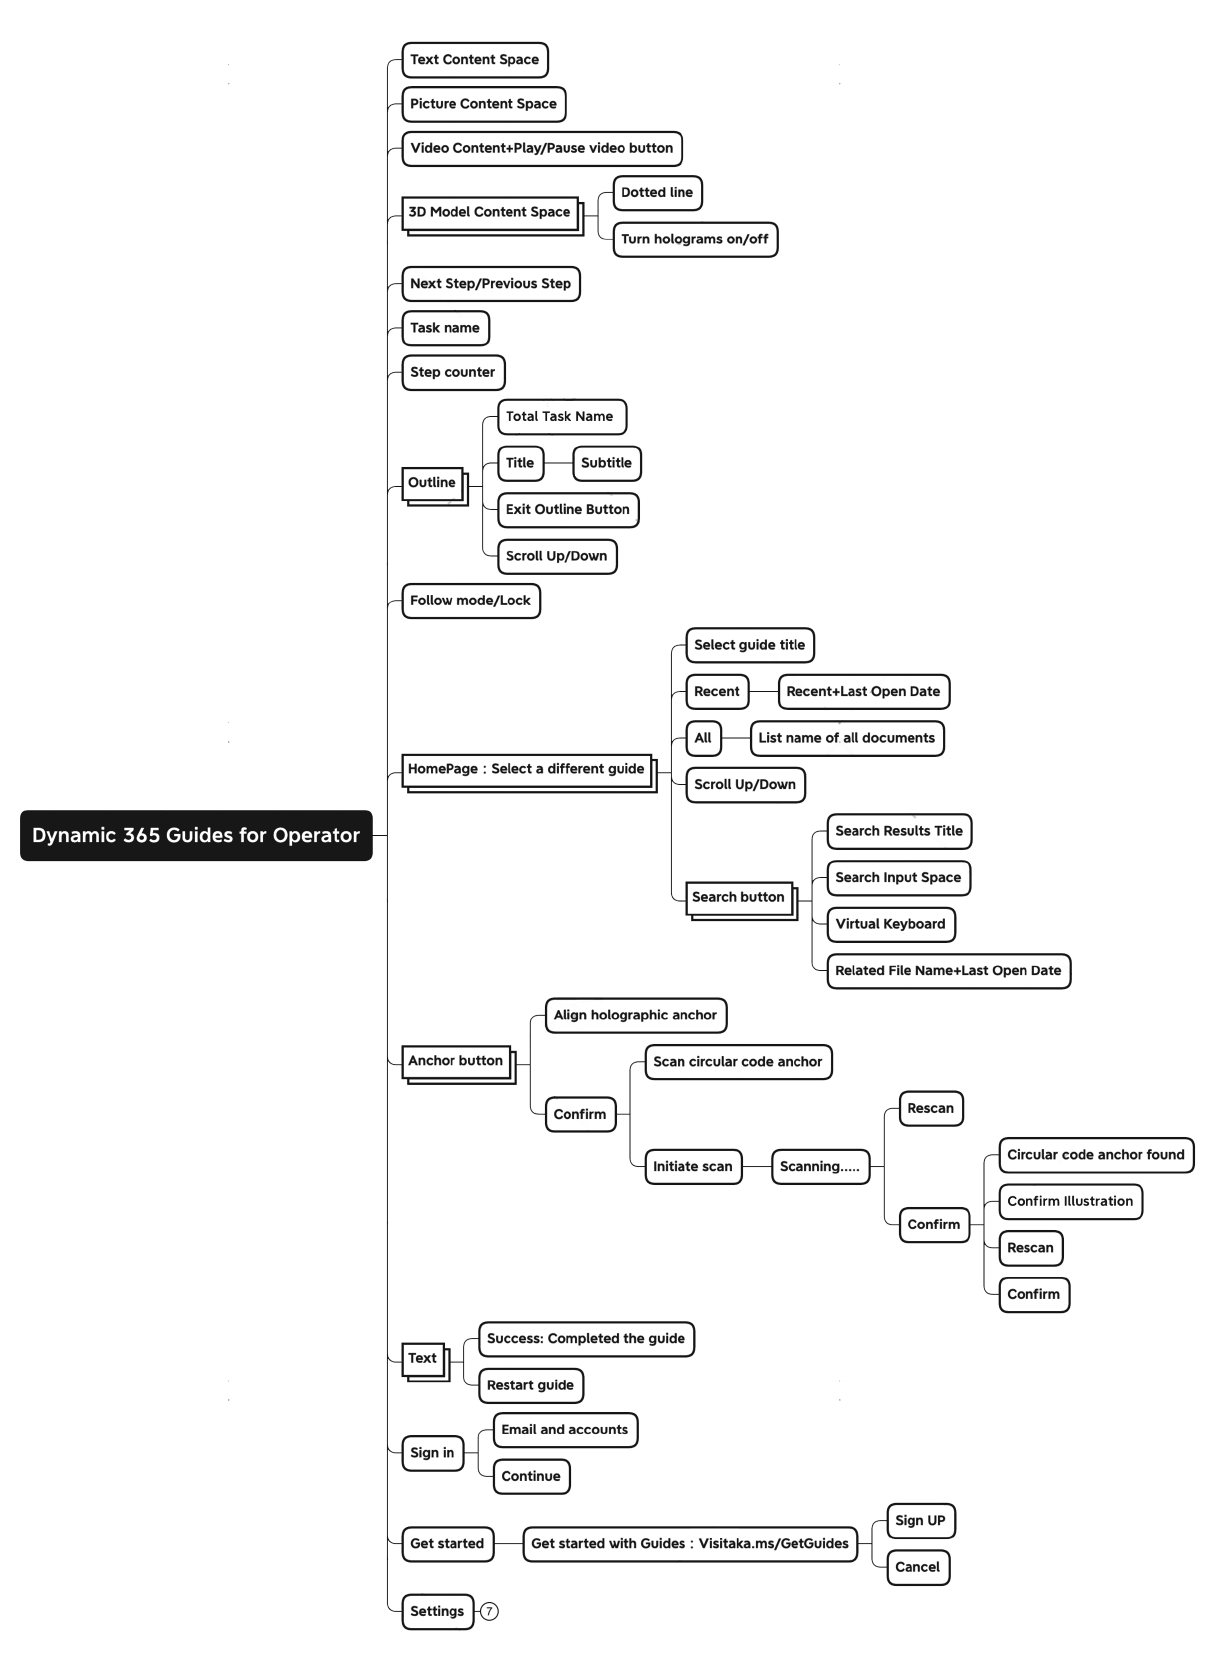
Figure 5. For an example of functional level analysis of Dynamic 365